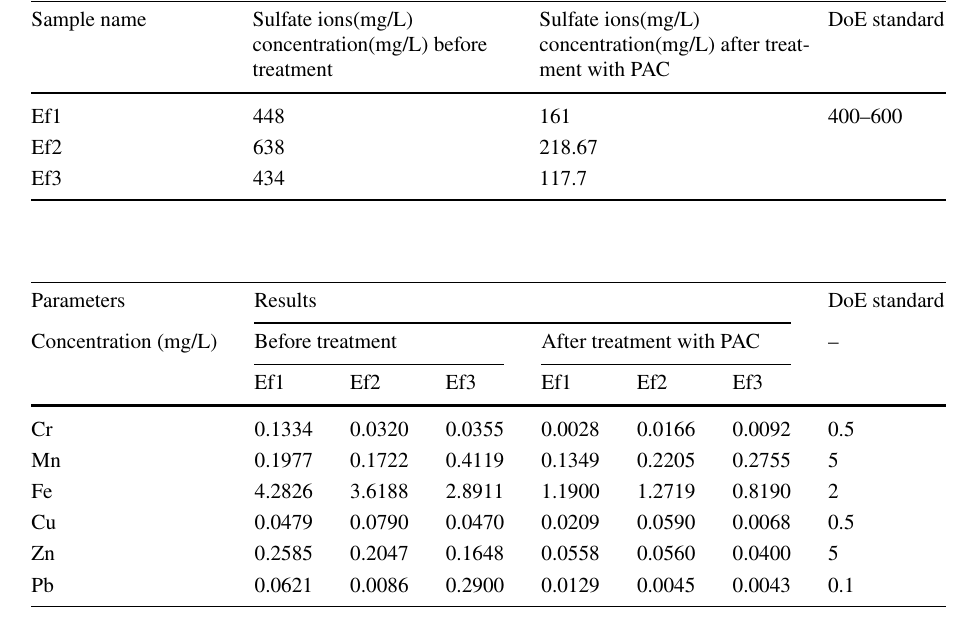
sulfates (SO 42− ) of textile effluents